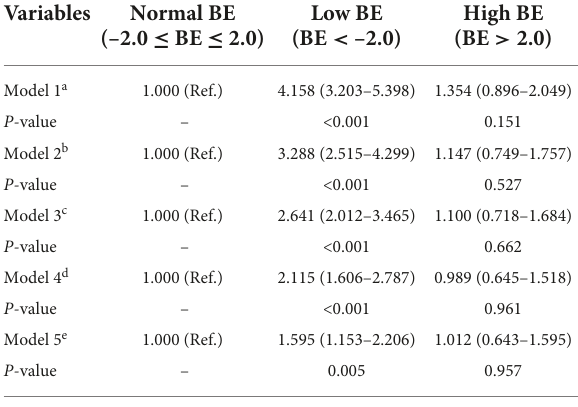
a Model1Univariatemodel. b Model2adjustedforage,gender,SBP,DBP. c Model3adjustedformodel2plushypertension,AF,COPD,AKI,SEPSIS,CHF. d Model 4 adjusted for model 3 plus Aspirin, Clopidogrel, Beta blockers, Diuretics, Digitalis,Statin,PCI,CABG. e Model5adjustedformodel4plusSodium,Potassium,ALB,BUN,Scr,AG,SpO 2 .